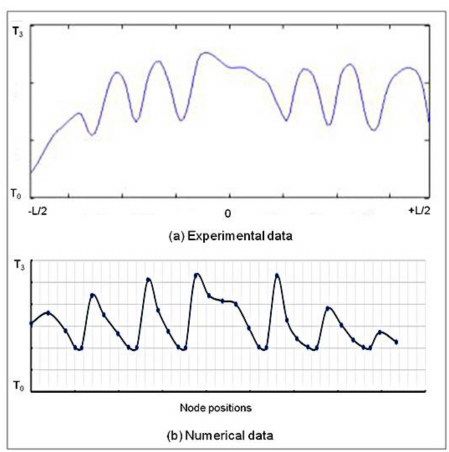
Figure 20. Temperature distribution on the cross-section of the tire tread loading with 200 kN rolling up to 114 km/h, with a skidding angle of 6, ( a ) experimental data, ( b ) numerical simulation. 3.3. Numerical Simulation of an Aircraft Tire Rolling on a Steel Drum, Loading with 200 kN, Velocity up to 190 km/h, Skidding Angle = 6 ◦